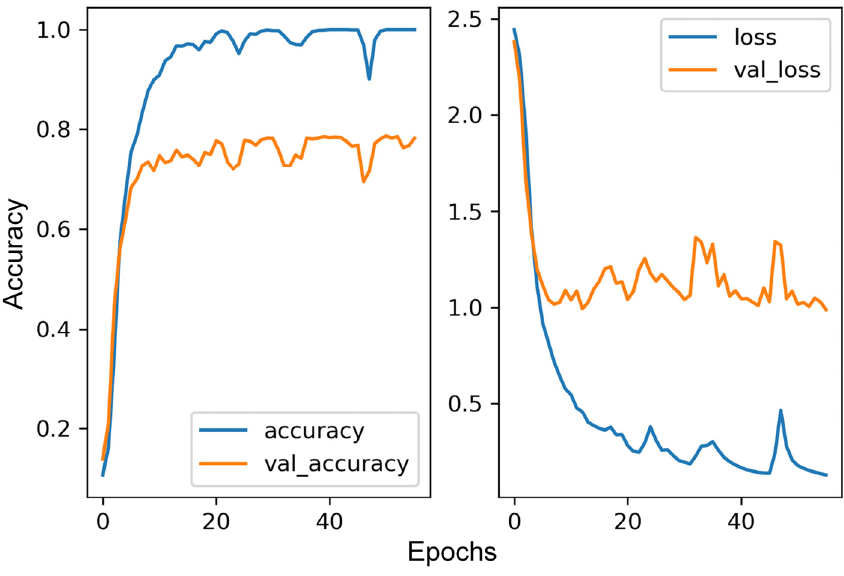
Figure 7. Learning curves of the baseline model with weight regularisation.